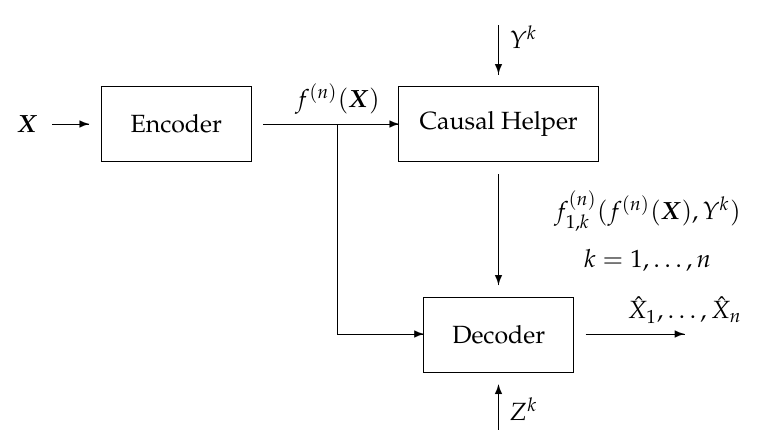
Figure 1. The causal listening-helper